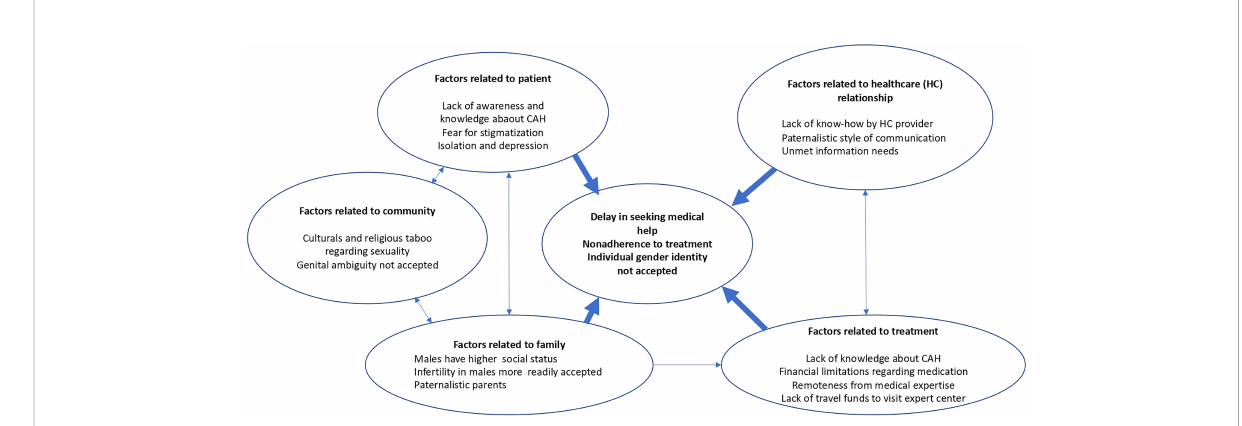
FIGURE 3 A practical model of factors related to delay in seeking medical help and nonadherence to treatment of patients with CAH in a developing country such as